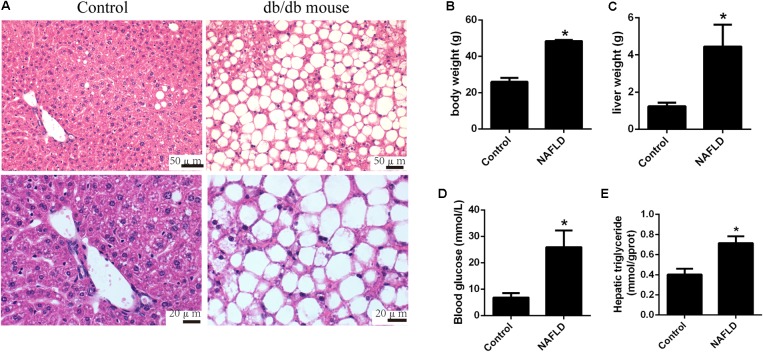
Pathological changes in db/db and control mice. (A) Representative images of the hematoxylin and eosin stained liver of db/db mice. (B) Body weight, (C) liver weight, (D) blood glucose level, and (E) hepatic triglyceride level of db/db and control mice. The values in bar graphs are means ± SD. ∗p < 0.05.